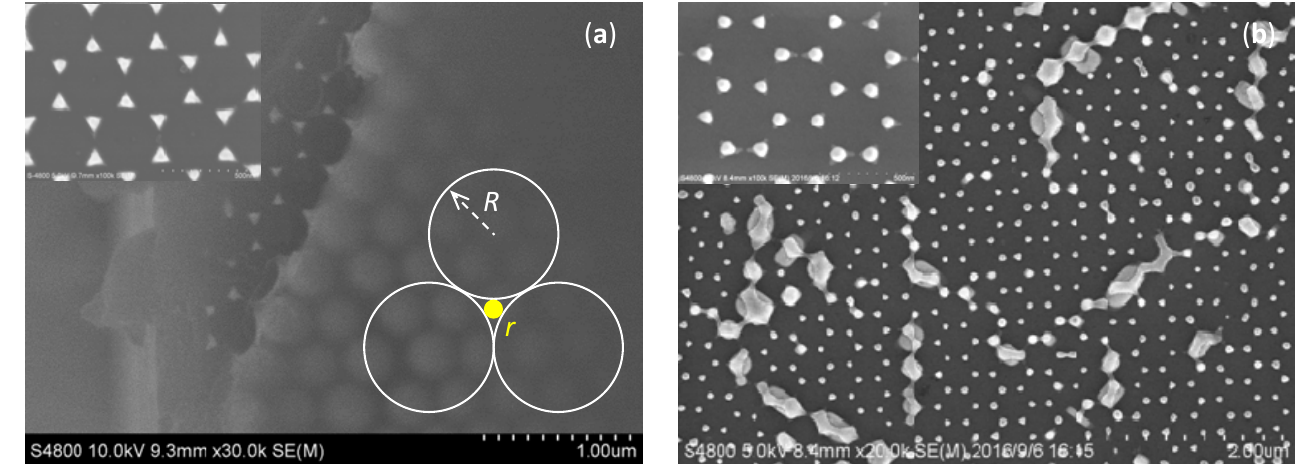
Figure 2. SEM images of ( a ) polystyrene sphere mono-film covered with a 300 nm-thick gold film, and ( b ) gold nanoparticle array after post treatment. The left up inset of ( a ) shows triangular gold array. The right down inset of ( a ) shows the geometrical relationship of polystyrene sphere and gold nanoparticle. The inset of ( b ) shows that the gold nanoparticle formed after annealing is well crystallized with a diameter of about 60 nm.